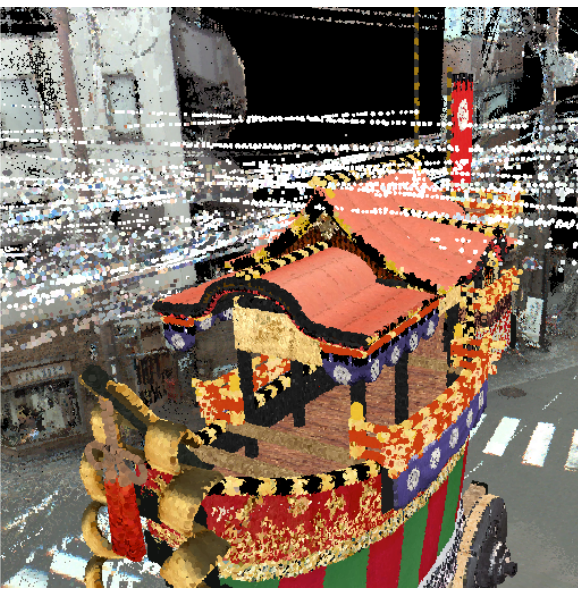
Figure 7. Point cloud of the Ofune-hoko float ( 9 . 7 × 10 ! points) placed in the scene of Figure 6.